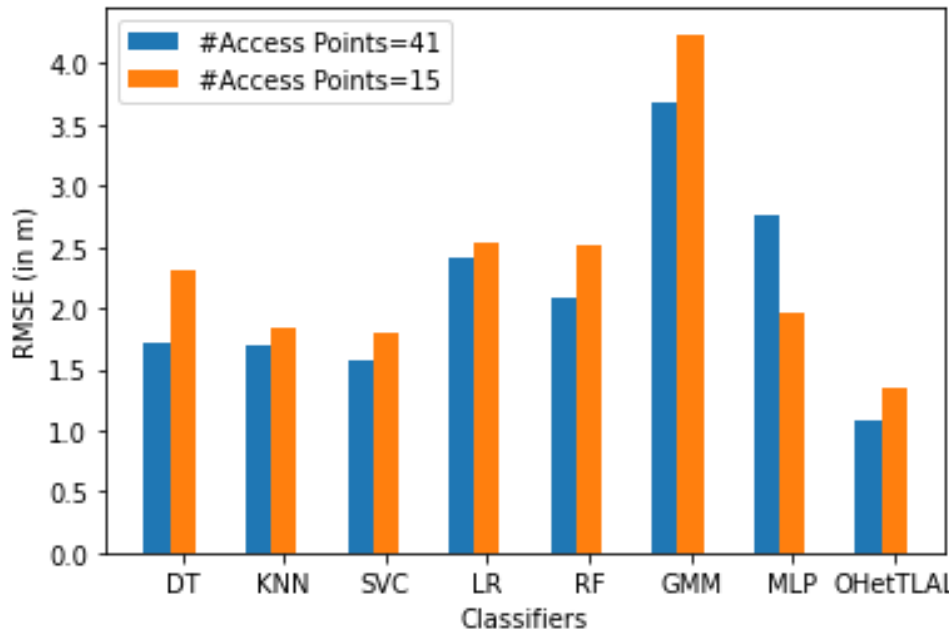
Figure 15. Effect of different feature spaces used to train classifiers for dataset A.